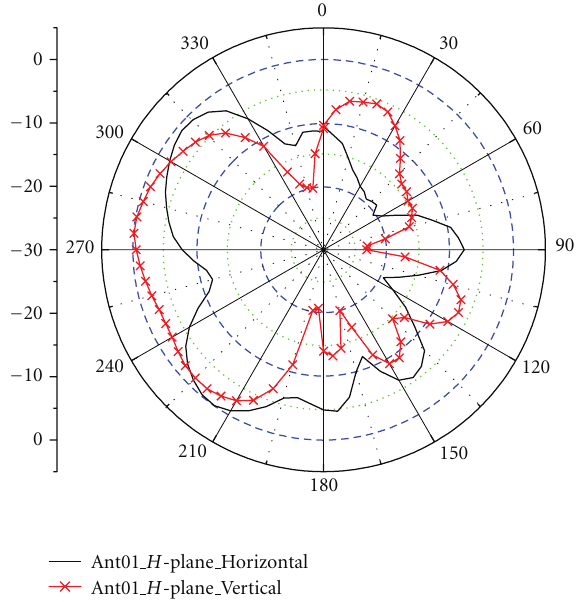
Figure 9: Measured H -Plane radiation pattern of antenna no. 1 at 1900 MHz.